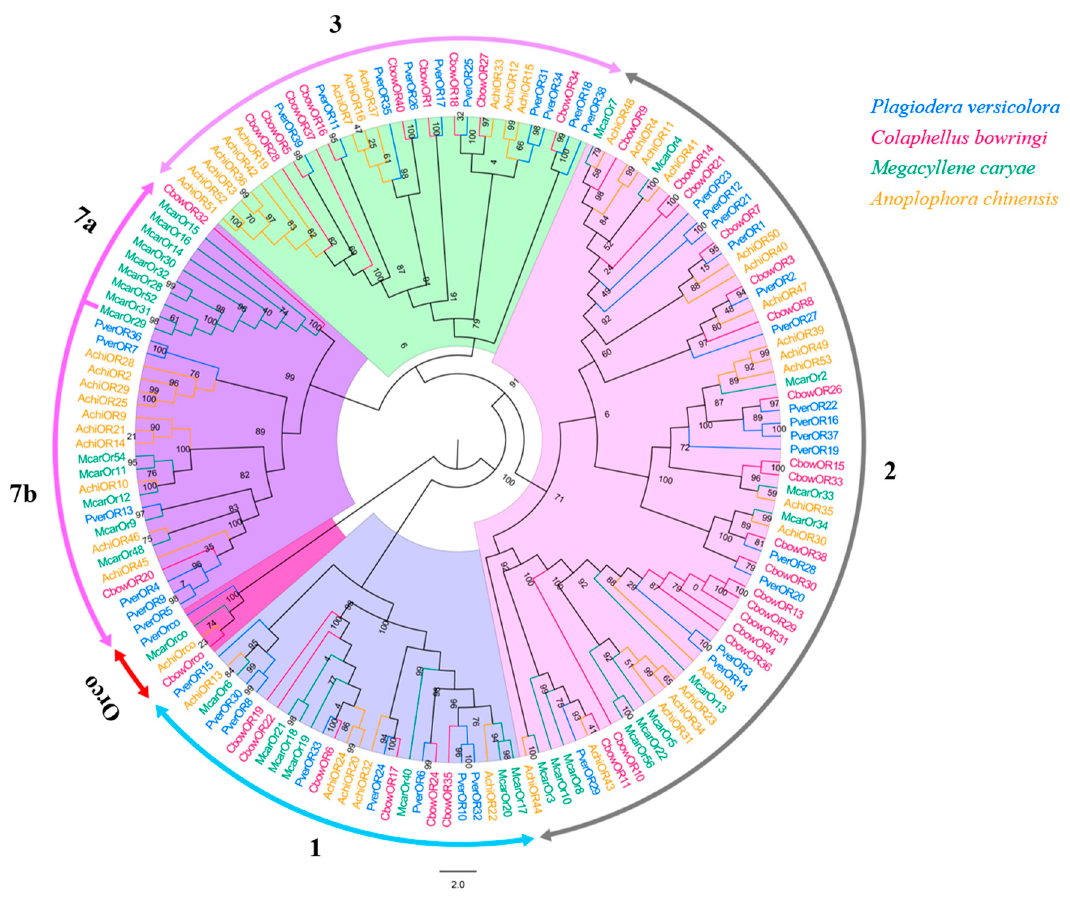
Figure 6. Phylogenetic tree of insect OR. The P. versicolora genes are shown in blue. The tree was constructed using MEGA6 with the Neighbor-joining method.